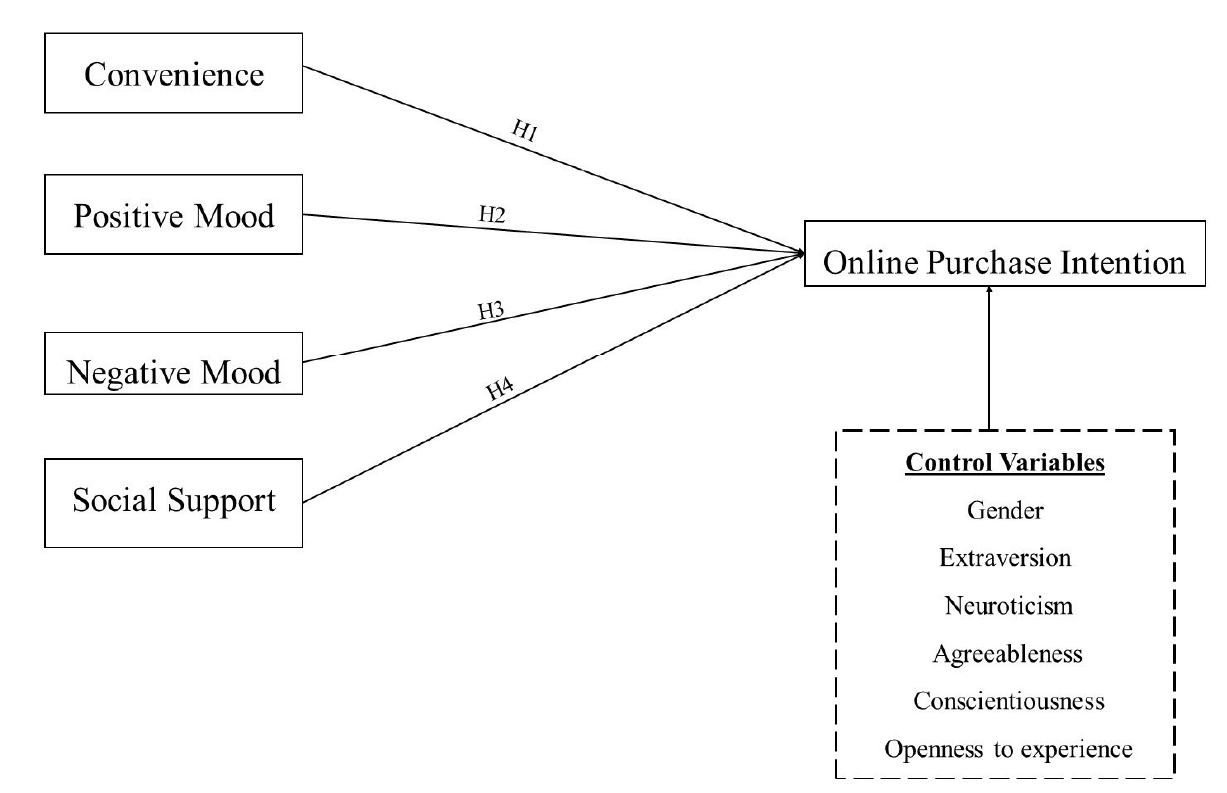
Figure 1. Research